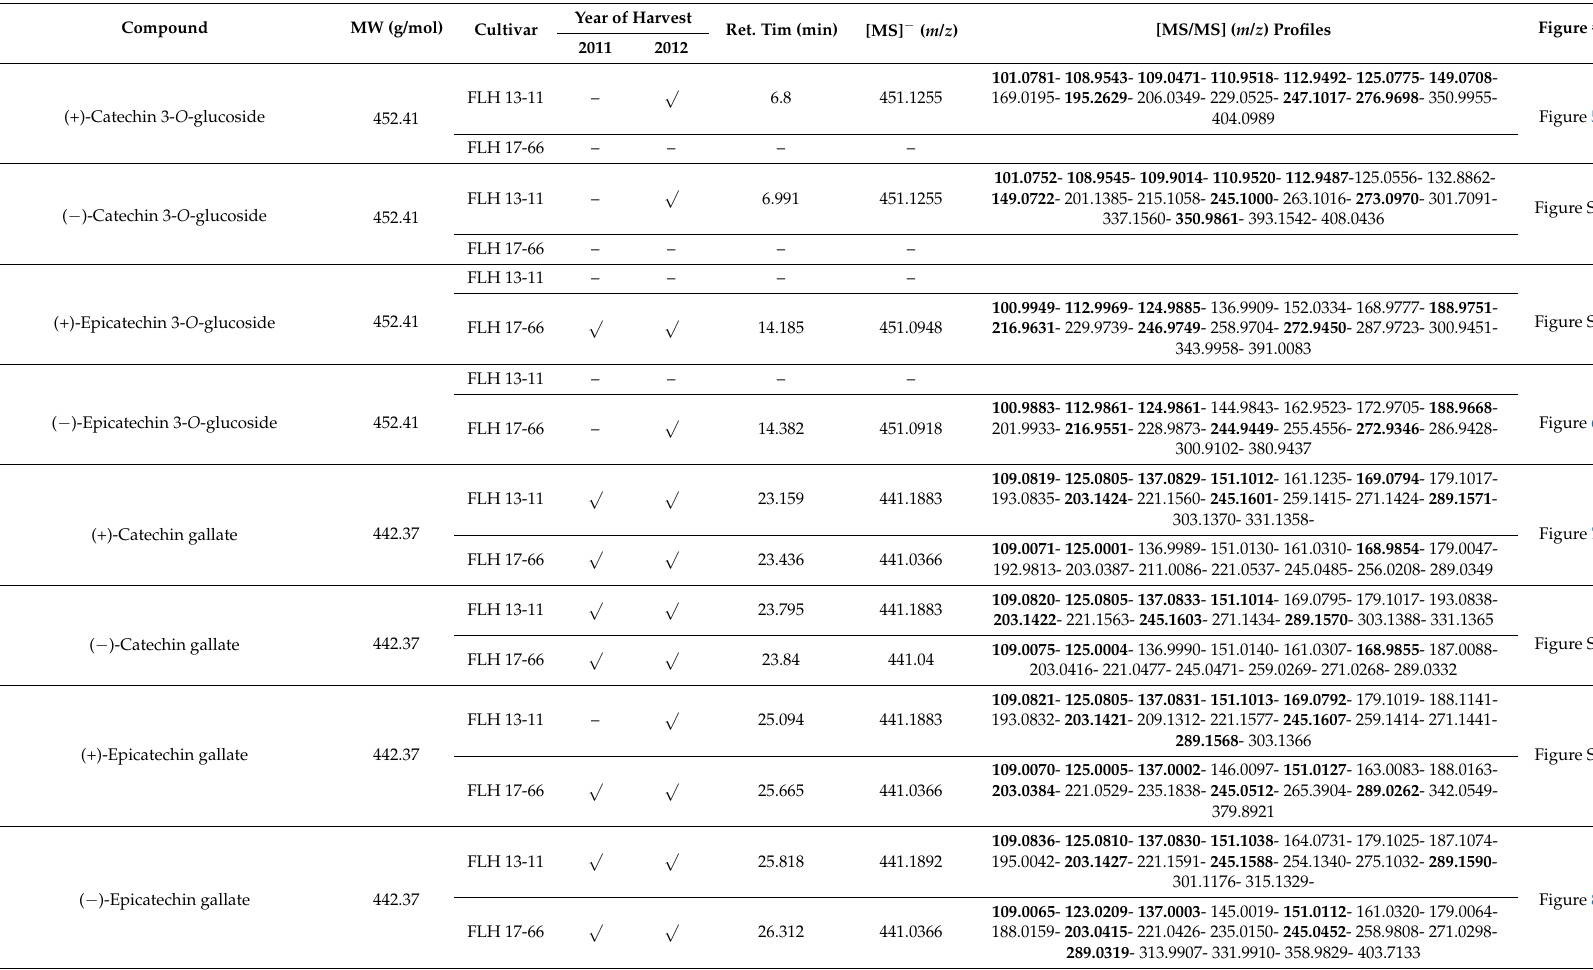
Table 3. Eighteen flavan-3-ol conjugates were detected in berries of two interspecific hybrid cultivars FLH 13-11 and FLH 17-66. Five commonly exist in two cultivars. Thirteen differentially occur in either of them and in either of growing seasons (Note: “–” means undetected, “